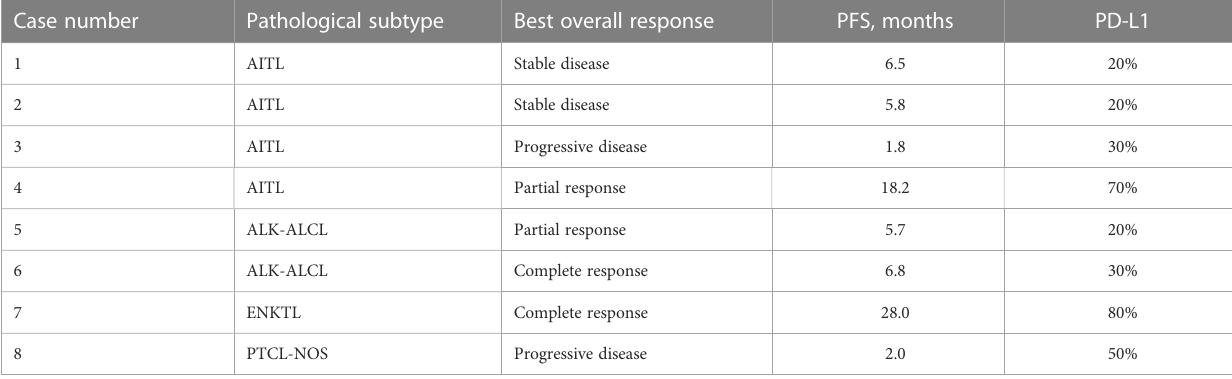
TABLE 3 Outcomes of eight patients with PD-L1 expression result.